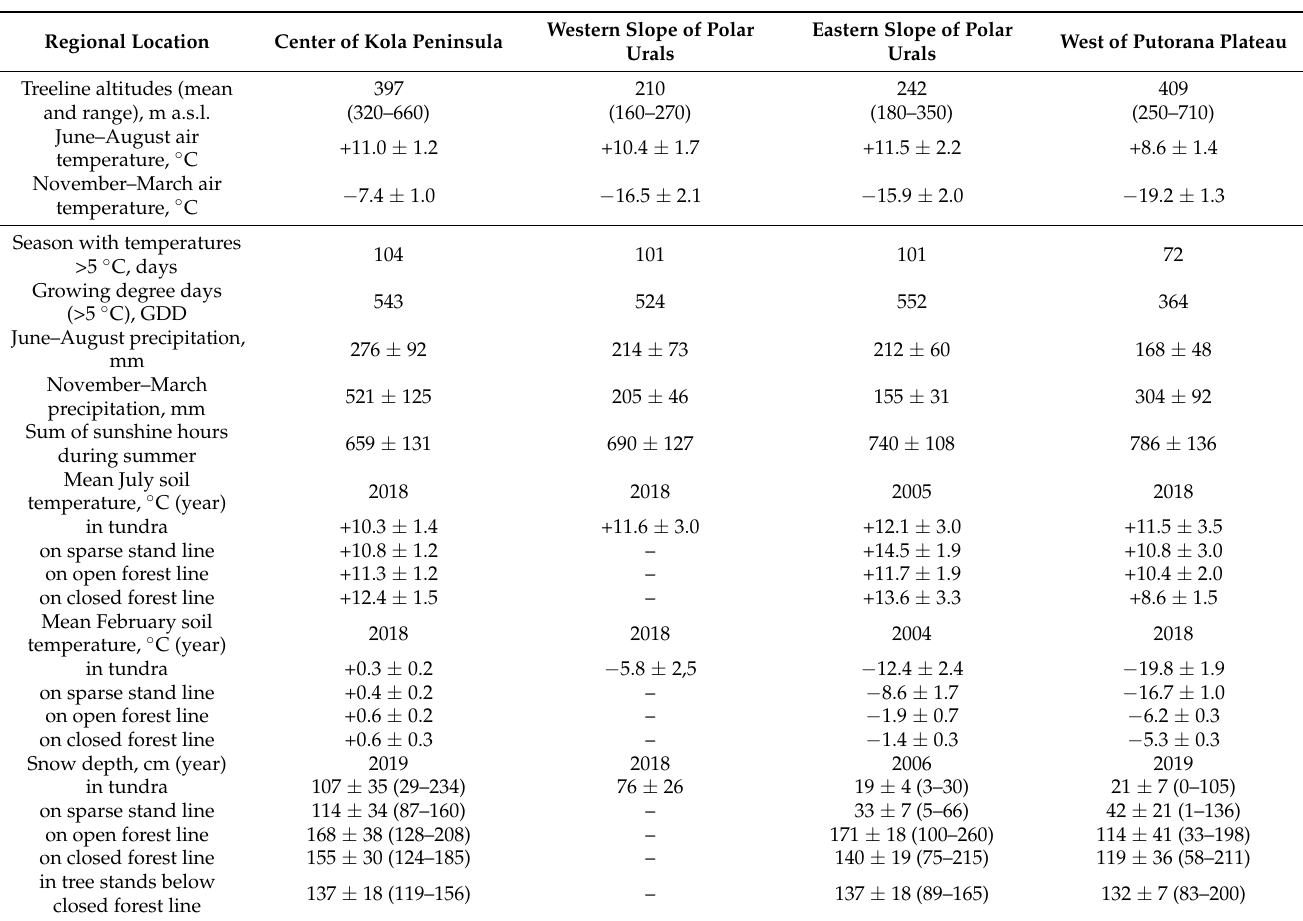
Table 6. Local conditions on the treeline sites in different studied subarctic regions of